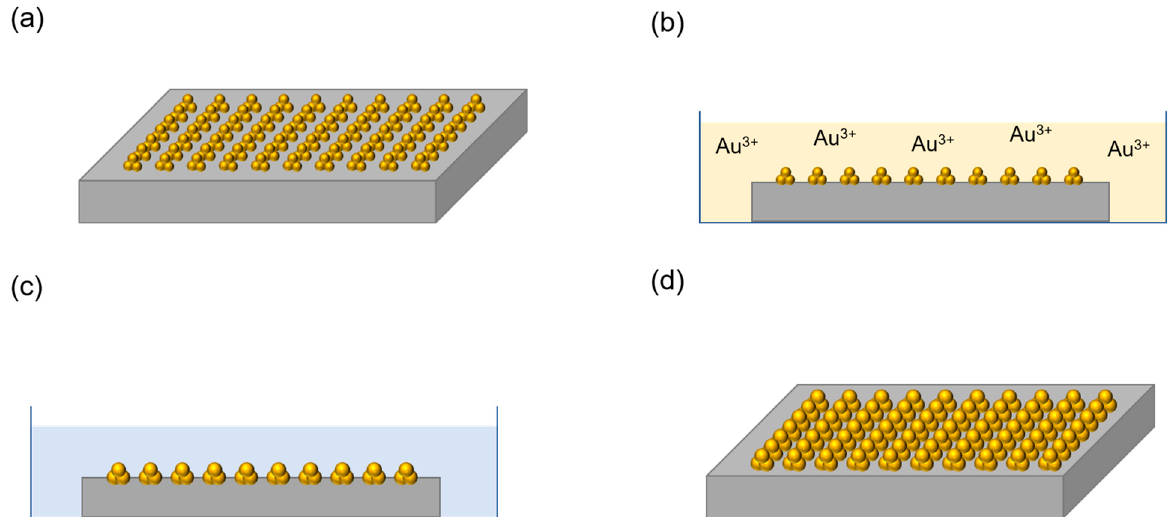
Figure 5. Scheme depicting the nucleation and the growth of the AuNSs created; ( a ) the first step is the creation via TPA–DLW of the AuNSs on the silicon substrate. After TPA–DLW, the AuNSs keep growing until a washing step with deionized water is carried out to dilute the solution and subsequently to remove the hydrogel; ( b ) then, in order to tune the size of the AuNSs, a second immersion in a 10 − 2 M HAuCl 4 solution is completed. This allows a controlled growth over time of the AuNSs through the migration of the Au 3+ ions towards the nanostructures and their reduction into Au 0 on the surface of the AuNSs by autocatalytic reduction; ( c ) a subsequent bath in deionized water stops the growth; ( d ) the AuNPs have grown in a controlled way as a function of the immersion time only where the AuNSs are lodged.